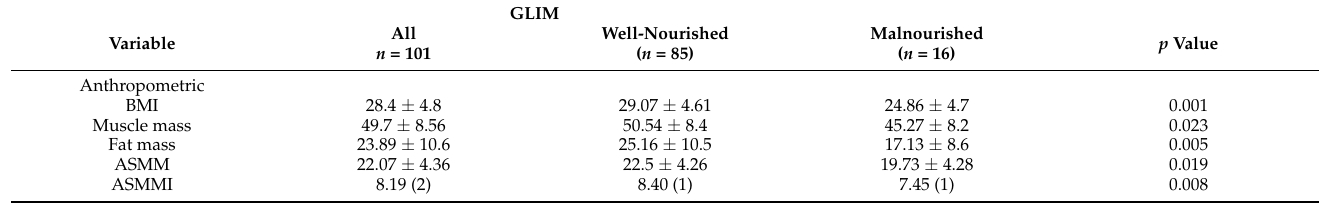
Table 1. Anthropometric characteristics of patients with T2DM according to the GLIM.